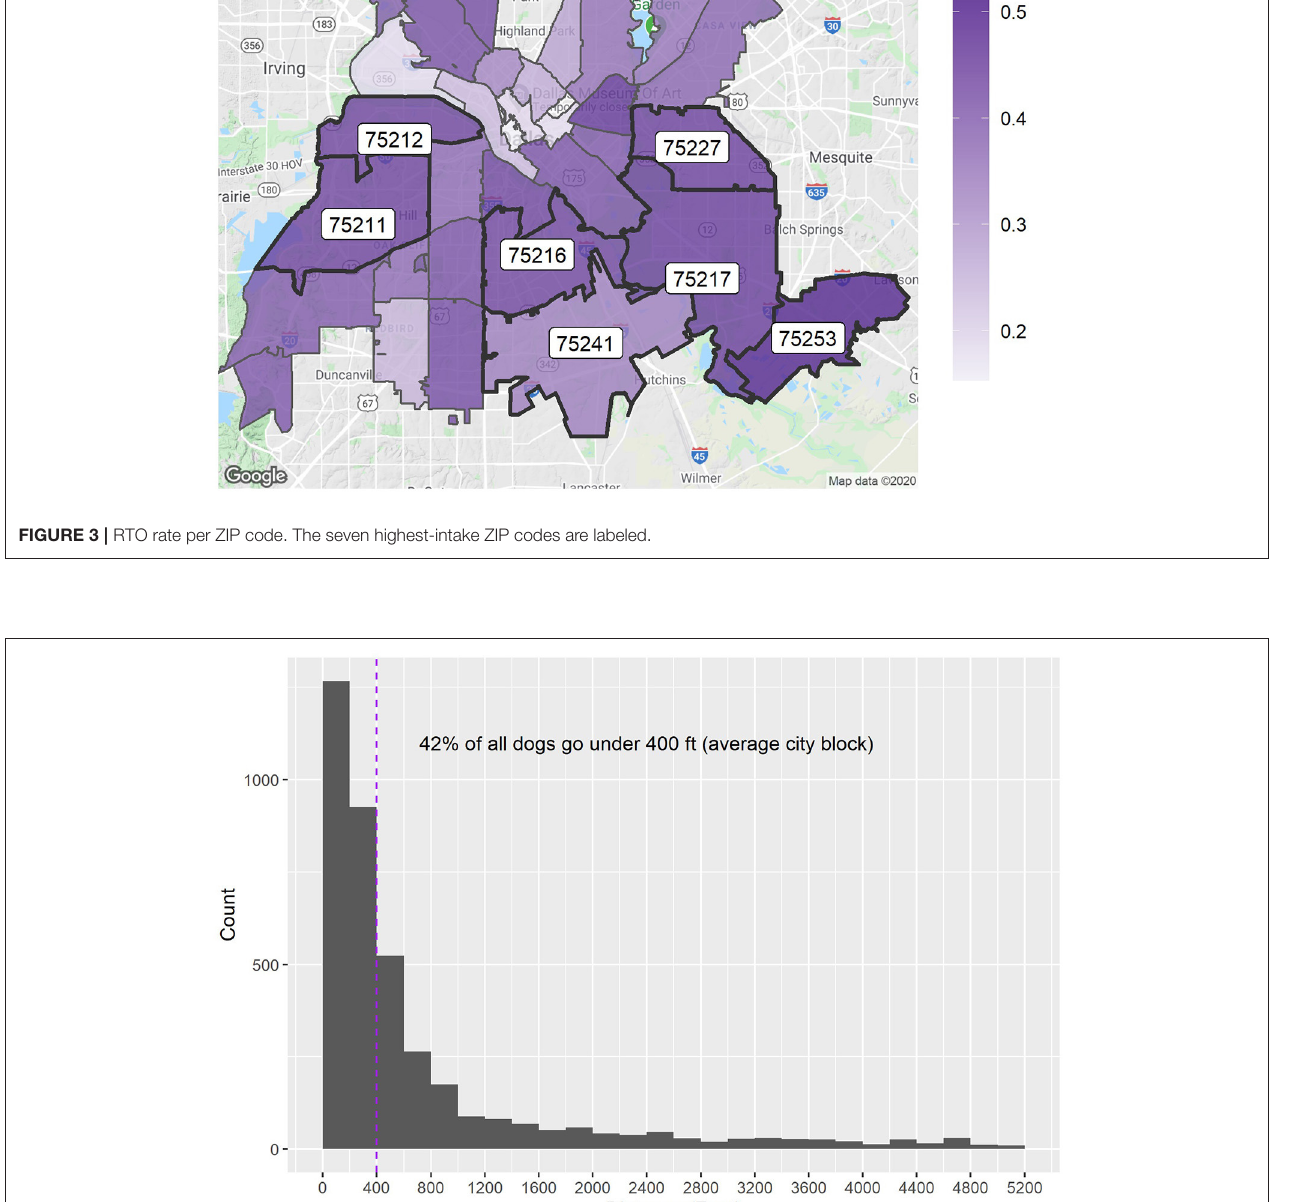
Frontiers in Veterinary Science |